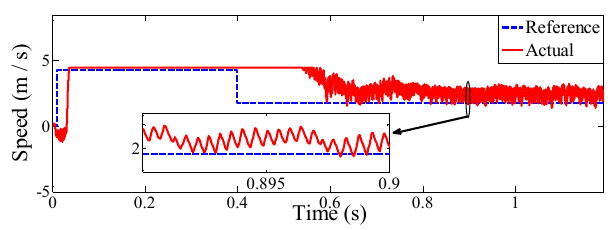
Fig. 4. Speed reference signal and actual speed of the motor by sliding mode observer.